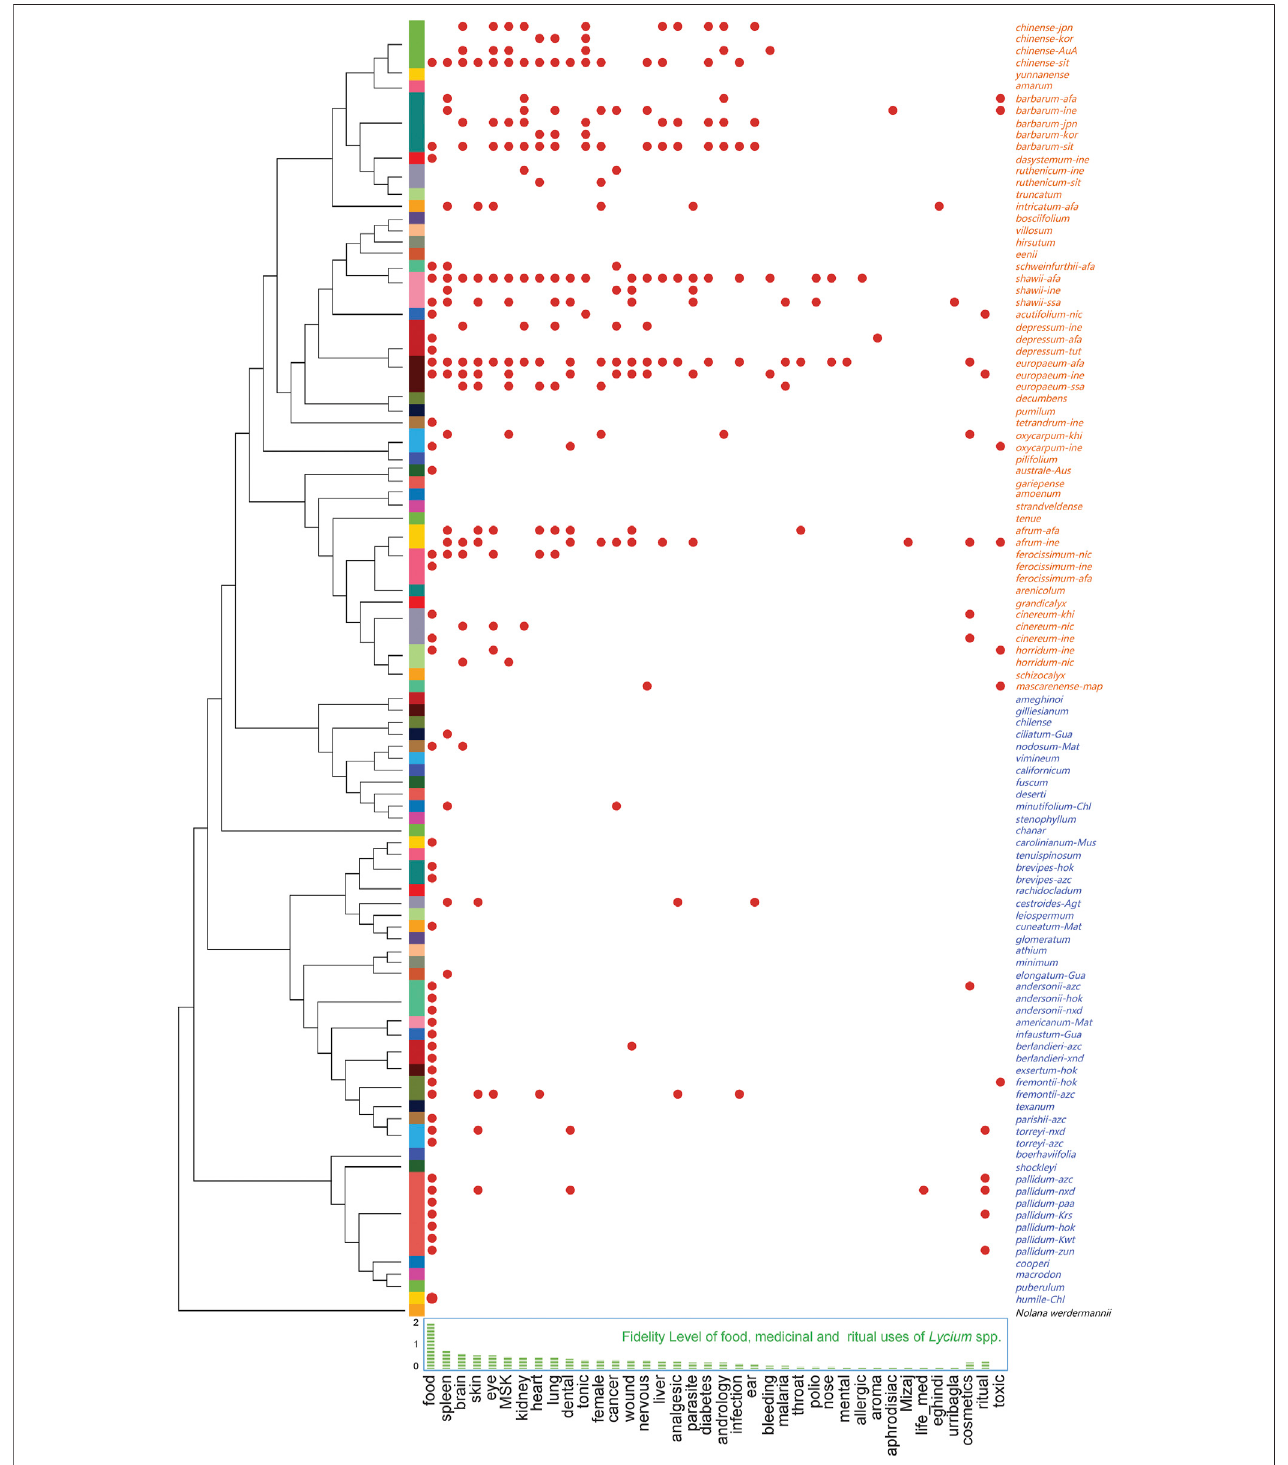
FIGURE 2 | The food, medicine, and ritual use of Lycium spp., with phylogenetic relationship reconstructed by sequences of the granule-bound starch synthase gene (GBSSI), and the Fidelity Level of the uses. Note that items are named as “ epitheton-language family ” (the Old World species are in orange and the New World species are in blue), and language families are obtained by WALS (The World Atlas of Language Structures) and international standards of ISO 639-2 and ISO 639-5; GBSSI sequences were retrieved from NCBI. Lists of language families, IDs of selected sequences, and references of the plant uses are presented in the Supplementary Material